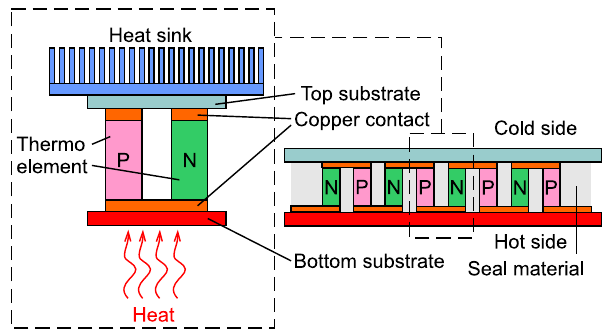
Figure 1. Principle scheme of a thermoelectric generator. The Seebeck effect is exploited to produce electrical energy.